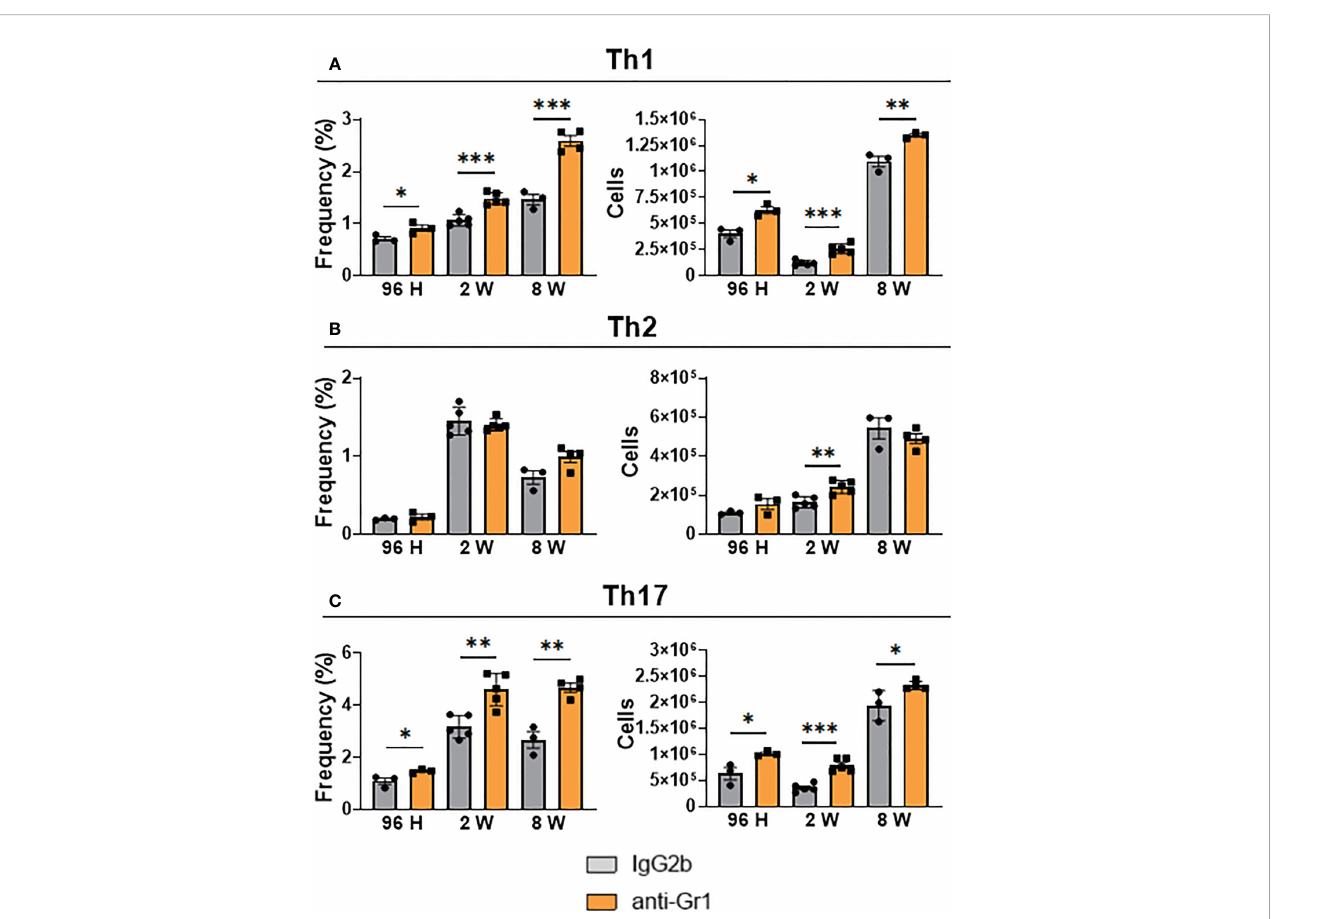
FIGURE 8 Effect MDSC depletion in the presence of pulmonary Th1, Th2, and Th17 lymphocytes of P. brasiliensis -infected mice. The presence of intracellular IFN- g , IL-4, and IL-17 in CD4 + T cells in the lung in fi ltrating leukocytes was assessed by intracellular cytokine staining by fl ow cytometry. After 24 hours, 1 week, and 7 weeks of infection a group of mice received intraperitoneal injections of anti-Gr1 (clone RB6-8C5) or rat IgG2b isotype control antibody (200 µg/ dose). After 96 hours, 2 weeks, and 8 weeks of infection, lung cells were stimulated in vitro with PMA/ionomycin + brefeldin A for 6 hours and subjected to intracellular staining. The lung-in fi ltrating lymphocytes were gated by FSC/SSC analysis. Lymphocytes were gated for CD4 expression and then for IFN- g (A) , IL-4 (B) , and IL-17 (C) expression. Results are expressed in frequency and the absolute number of cells and are representative of three independent experiments. For comparisons between two groups, the mean ± SEM was obtained and analyzed by the unpaired Student ’ s t -test. Differences were considered signi fi cant when: * p <0.05; ** p <0.01 and *** p